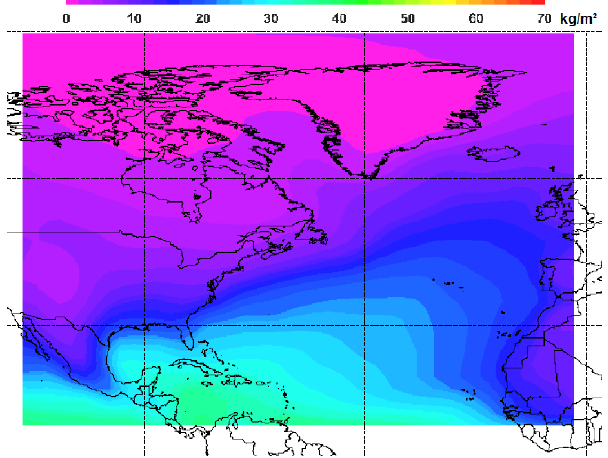
Figure 5. Average value of the total precipitable water over thirty years (1979-2009) obtained 3 Fig. 5. Average value of the total precipitable water over thirty for the month of February from the NCEP/DOE AMIP-II Reanalysis (Reanalysis-2). 4 years (1979–2009) obtained for the month of February from the NCEP/DOE AMIP-II Reanalysis (Reanalysis-2).